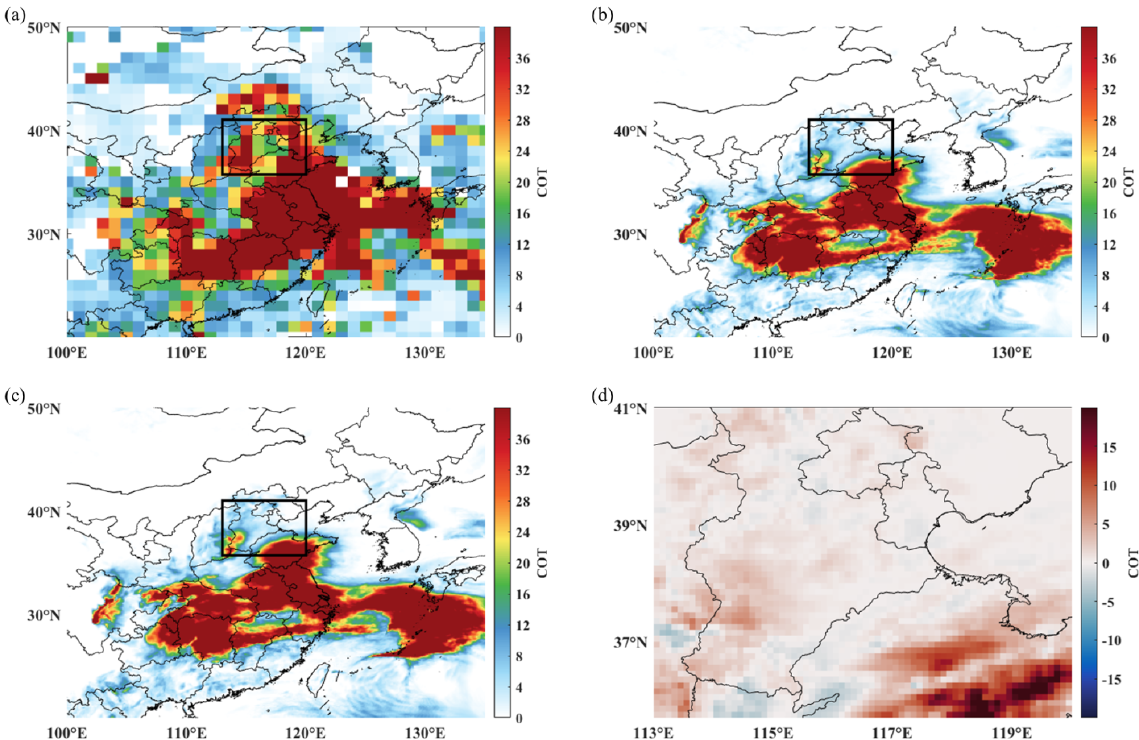
Figure 6. As in Fig. 5 but for mean COT on 7 January 2017.